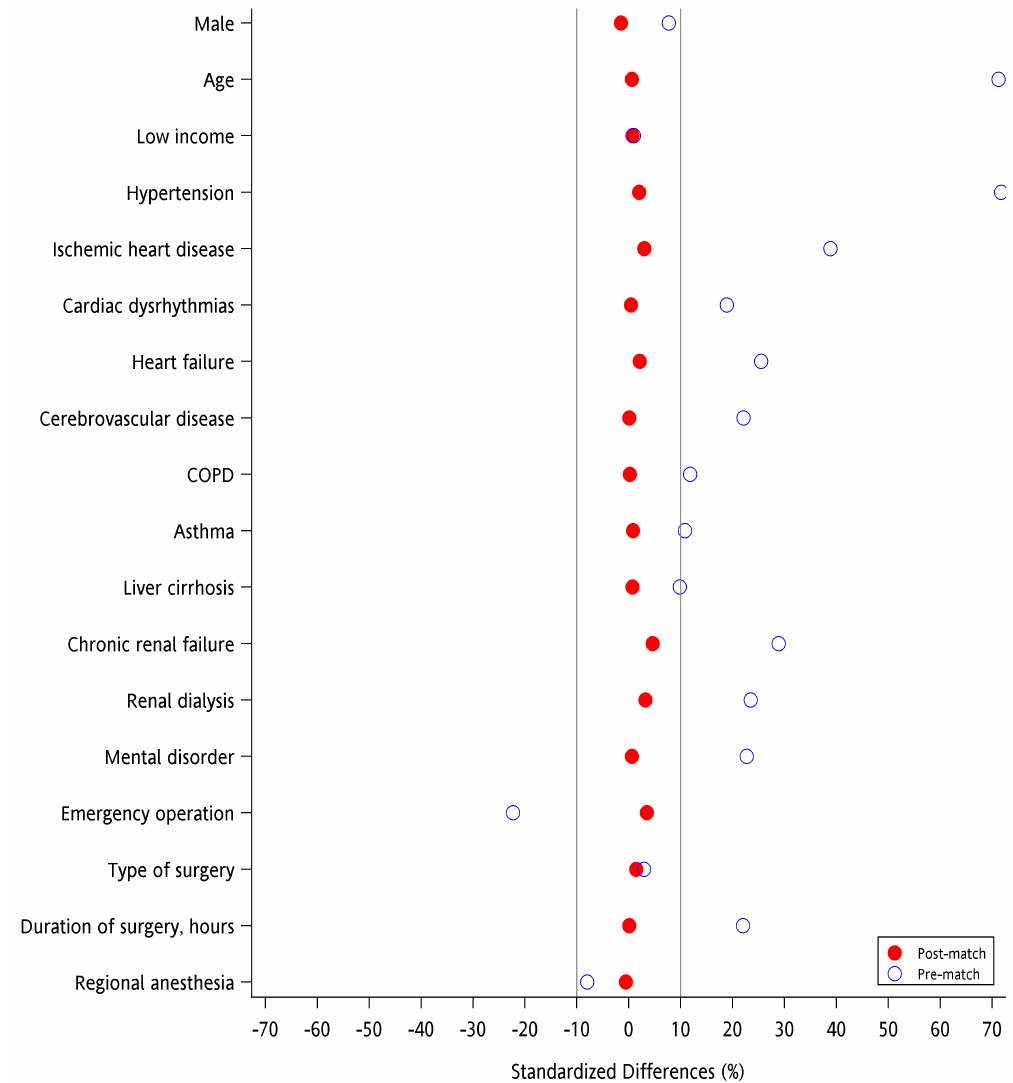
Figure A2. The standardized differences of baseline covariates between surgical patients with and without diabetes.